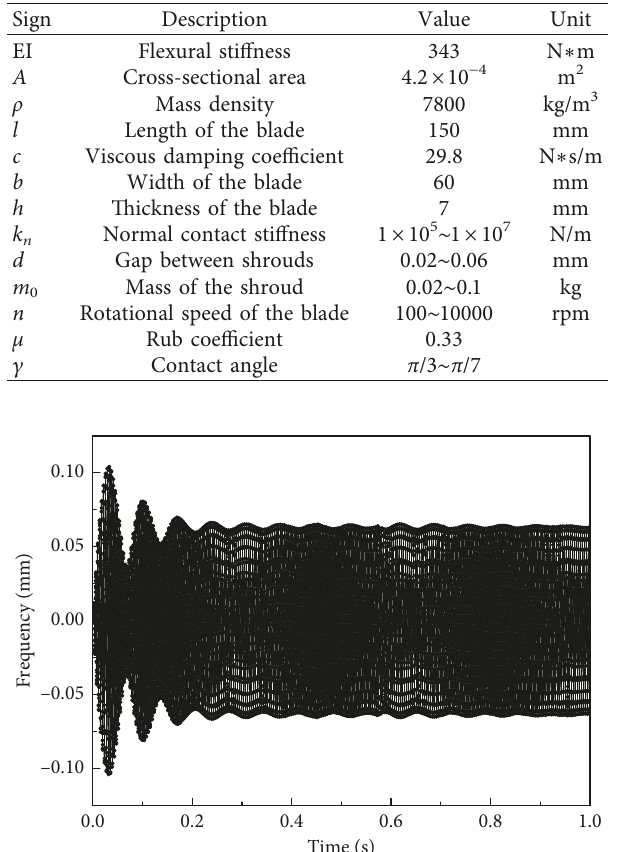
Figure 4: Time-domain response of the tip at the rotating speed 5000rpm.